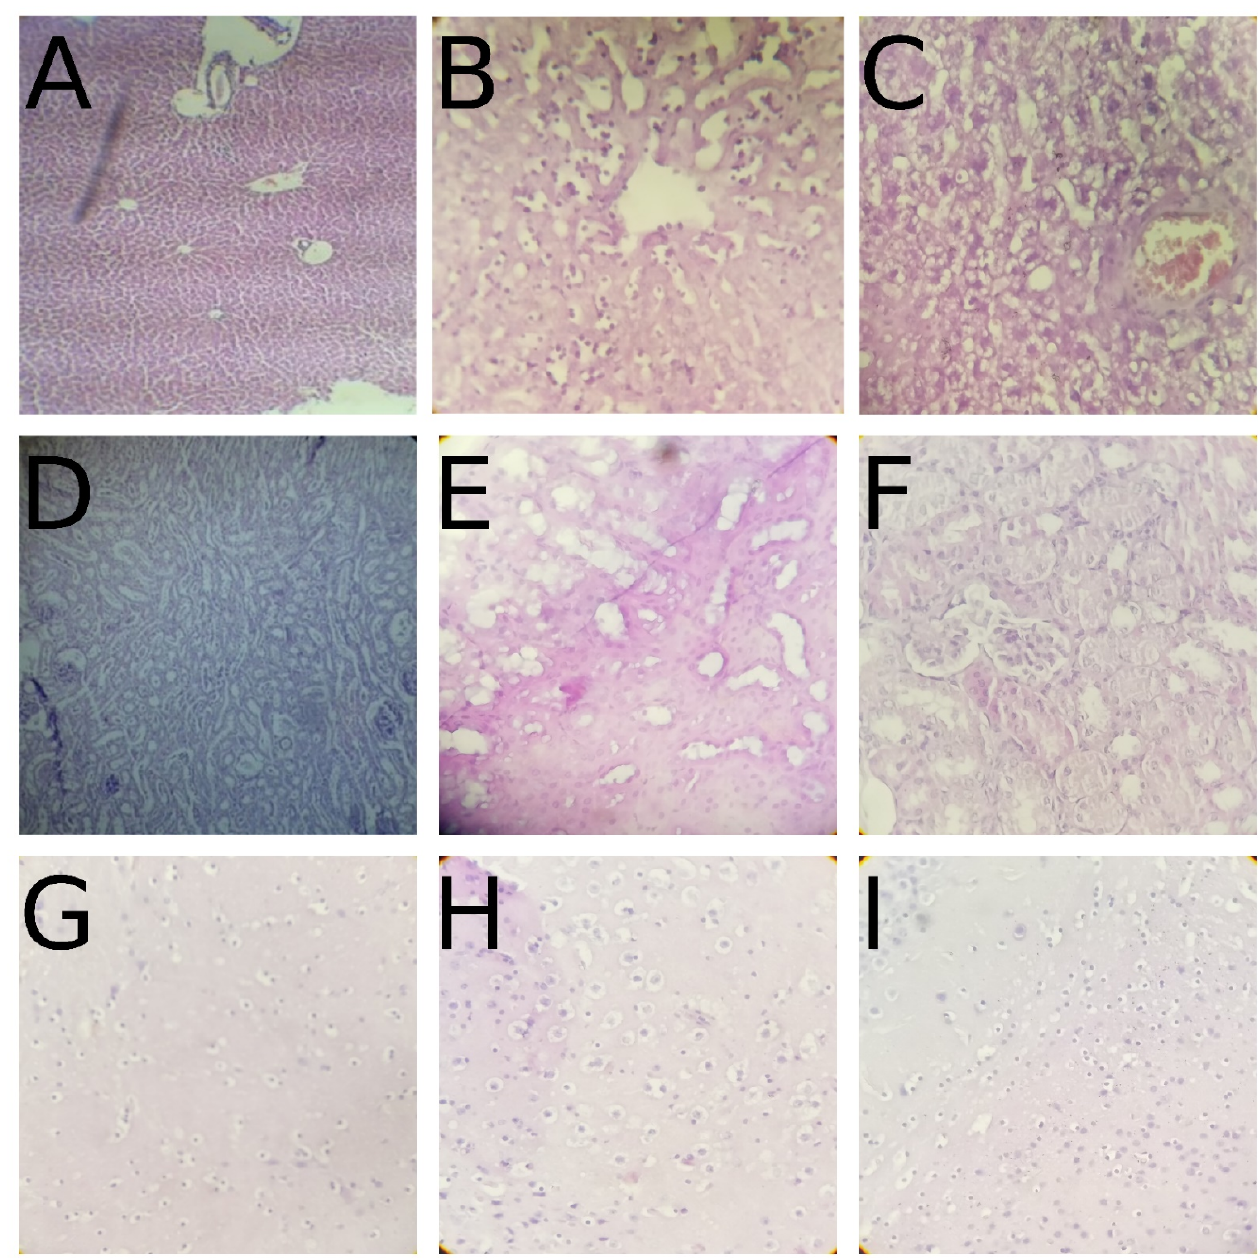
Figure 6. Histopathological examination of liver, kidneys, and brain of mice in the chronic oral toxicity study. ( A , D , G ) The control group; ( B , E , H ) the group treated with 10.0 mg/kg of the VBZ102; ( C , F , I ) the group treated with 1.0 mg/kg of the VBZ102. ( A , D , G ) Normal cells. ( B ) Nuclear degenerescence, vacuolation, and steatosis within cells; the nuclei are not centered, although, there is no inflammatory infiltrate around the centrilobular vein. ( E ) Normal cells. ( H ) Presence of a clear halo around perivascular halo vessels. ( C ) Degeneration of the plasma membrane, vacuolation, steatosis, and infiltrate around the centrilobular vein. ( F ) Normal cells. ( I ) Normal cells (hematoxylin and eosin (H&E) ×400).